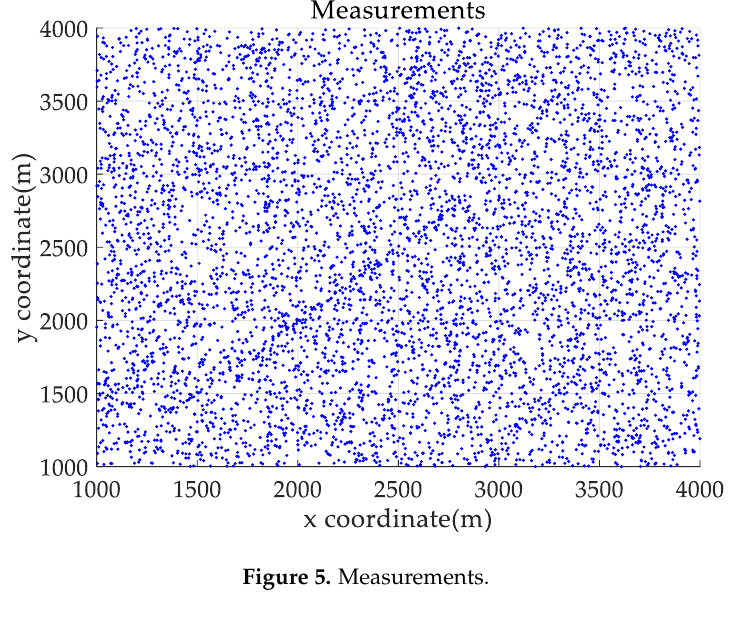
Figure 5. Measurements. Figure 5.